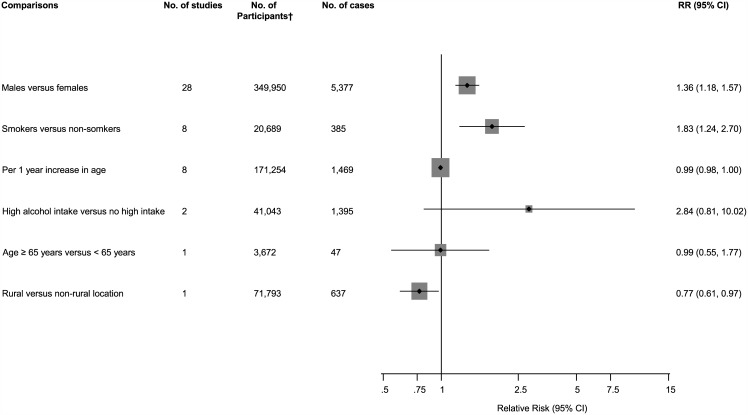
Sociodemographic characteristics comparisons and risk of periprosthetic joint infection.CI, confidence interval (bars); RR, relative risk; †, are number of participants or arthroplasties.